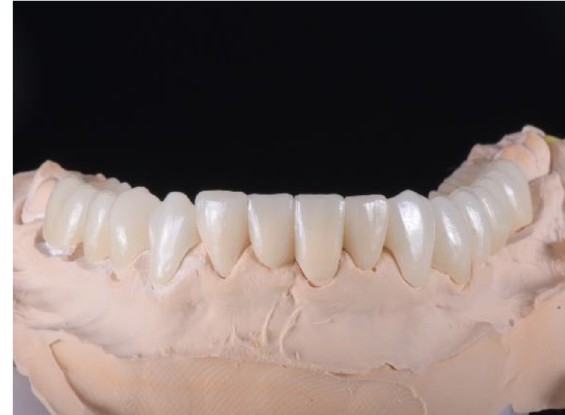
Figure 18. Zirconia prosthesis on the